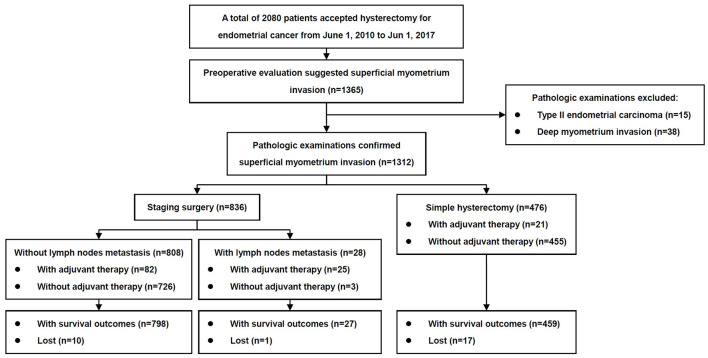
Flow diagram of the study.